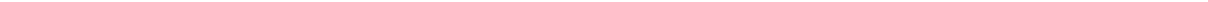
Fig. 5 Pro fi ling of the pan-RAF inhibitor LY-3009120 and the paradox breaker PLX-0012. a Structure of LY-3009120, PLX4720, and the Paradox Breaker PLX-0012. Dose-response analysis of LY-3009120, PLX4720 and PLX-0012 with BRET biosensors measuring BRAF kinase domain dimerization b , KRAS- BRAF association d , and BRAF intramolecular interaction f . LY-3009120, PLX4720, and PLX-0012 have distinct propensities to promote BRAF – CRAF dimerization c , to stimulate KRAS-RAF association e , and to perturb BRAF autoinhibition g as measured by co-IP experiments. Cells were treated with 10 µ M of each indicated compound. PLX4720 h and PLX-0012 i induce CRAF − BRAF dimerization in a RAS-independent manner. Full-length BRAF − CRAF dimerization was measured in the presence of dominant-negative KRAS S17N (gray) or RBD-mutated BRAF R188L and CRAF R89L (RL; blue). Expression of active KRAS G12V potentiated the effect of PLX4720 and PLX-0012 on BRAF − CRAF dimerization (orange and cyan, respectively). Each EC 50 was the average of three independent replicates. j Maximum pERK signal reported in Table 1 was plotted against its corresponding concentration in each cell line. Each compound is represented by a distinct color: LY-3009120 (red), PLX4720 (orange), and PLX-0012 (blue). To facilitate comparison between conditions, the range between minimal and maximal BRET signals was normalized to 100% in panels h and i. Error bars in dose-response curves correspond to mean values ± s.d. of technical duplicates of a representative biological triplicate. EC 50 s are the average of at least three independent repeats (Supplementary Data 1). Error bars in j correspond to mean values ± s.d. of biological